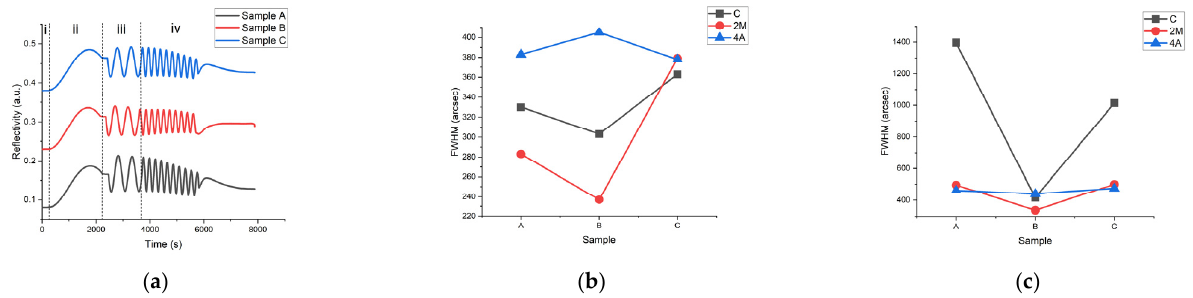
Figure 2. The in-situ reflectivity of 2M of three samples: A, B, and C. Stage (i): baking and initial treatment of the substrate; stage (ii): the high-temperature AlN layer; stage (iii): low-speed GaN; stage (iv): high-speed GaN. ( a ) XRD FWHM results for samples A, B, and C at approximately a (002) reflection ( b ) and a (102) reflection, and ( c ) grown on C, 2M, and 4A sapphire substrates.